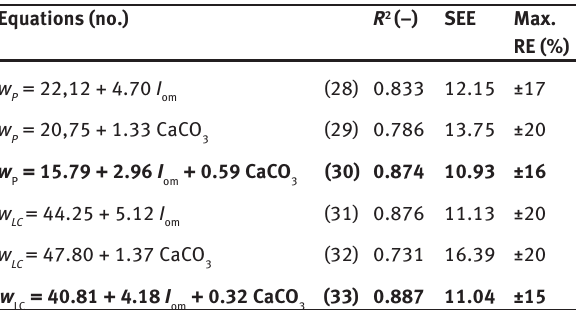
Table 5: Single- and two-factor linear regression models of the plastic limit ( w ) and liquid limit ( w ) relationship versus the organic P LC matter content ( I ) and/or calcium carbonate content (CaCO om relationship for Eemian gyttja. Equations